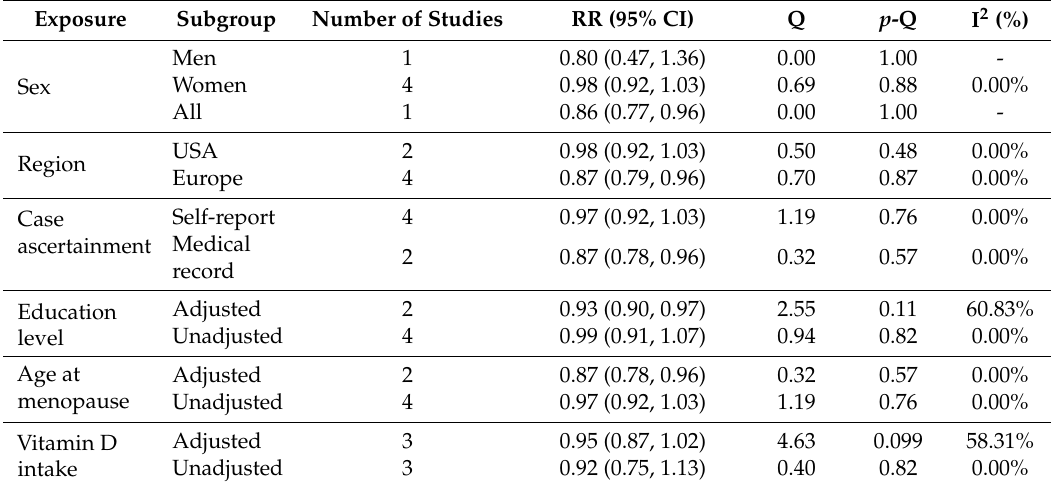
Table 3. Subgroup analyses for retinol intake and total fracture.